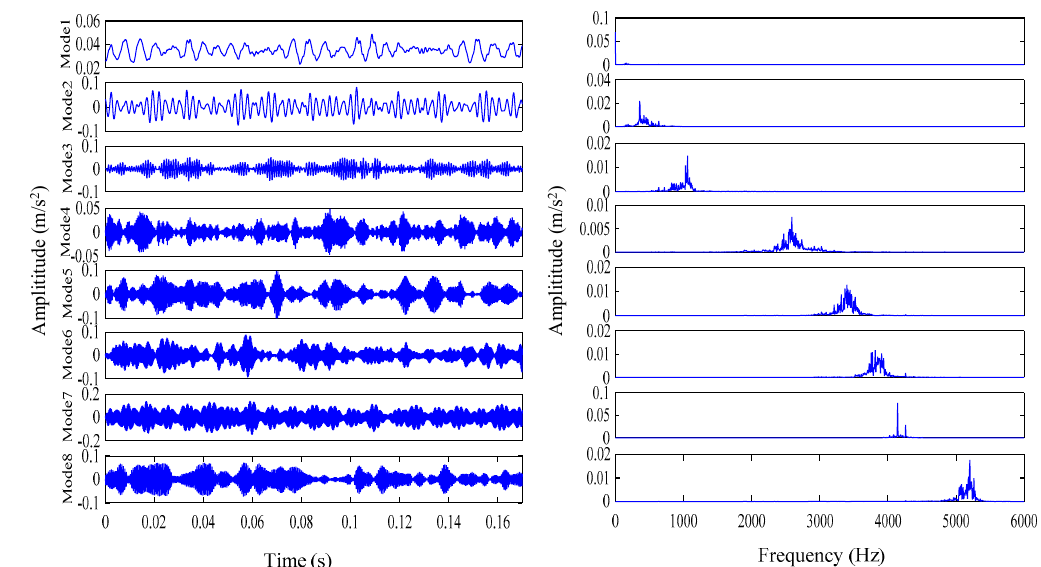
Figure 31. Decomposition results and corresponding frequency spectrum of the IMFs for challenging signal with IVMD.